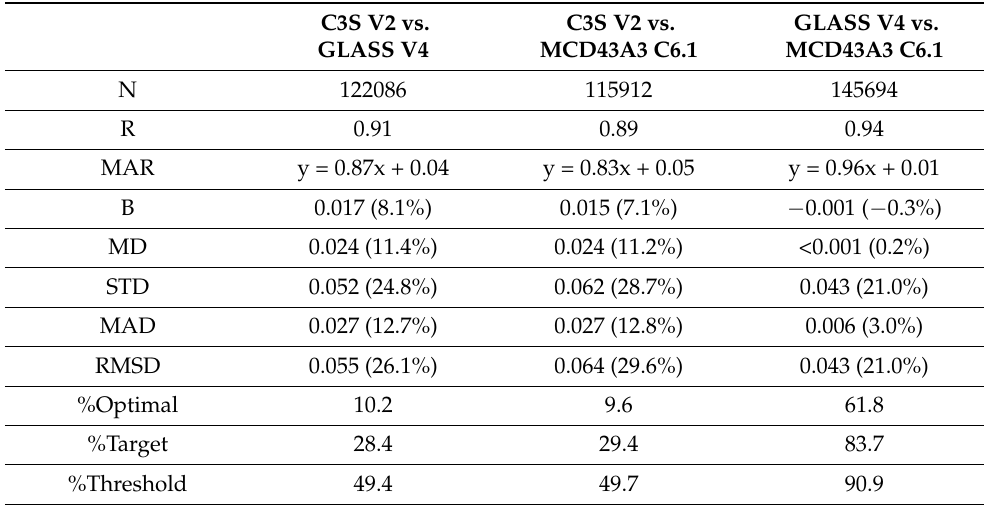
Table 10. Summary of the main statistics for scatterplots between C3S V2 vs. GLASS V4, C3S V2 vs.